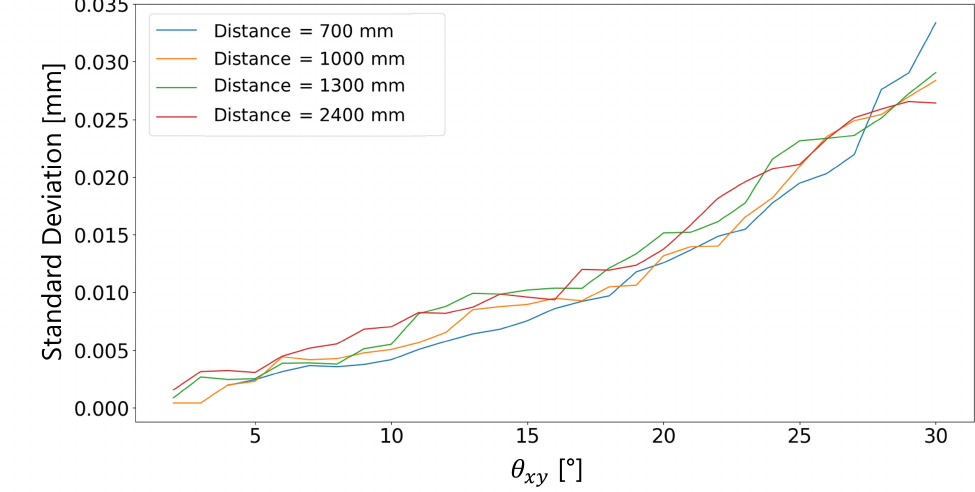
Figure 21. Standard deviation in mm vs. absolute angle.